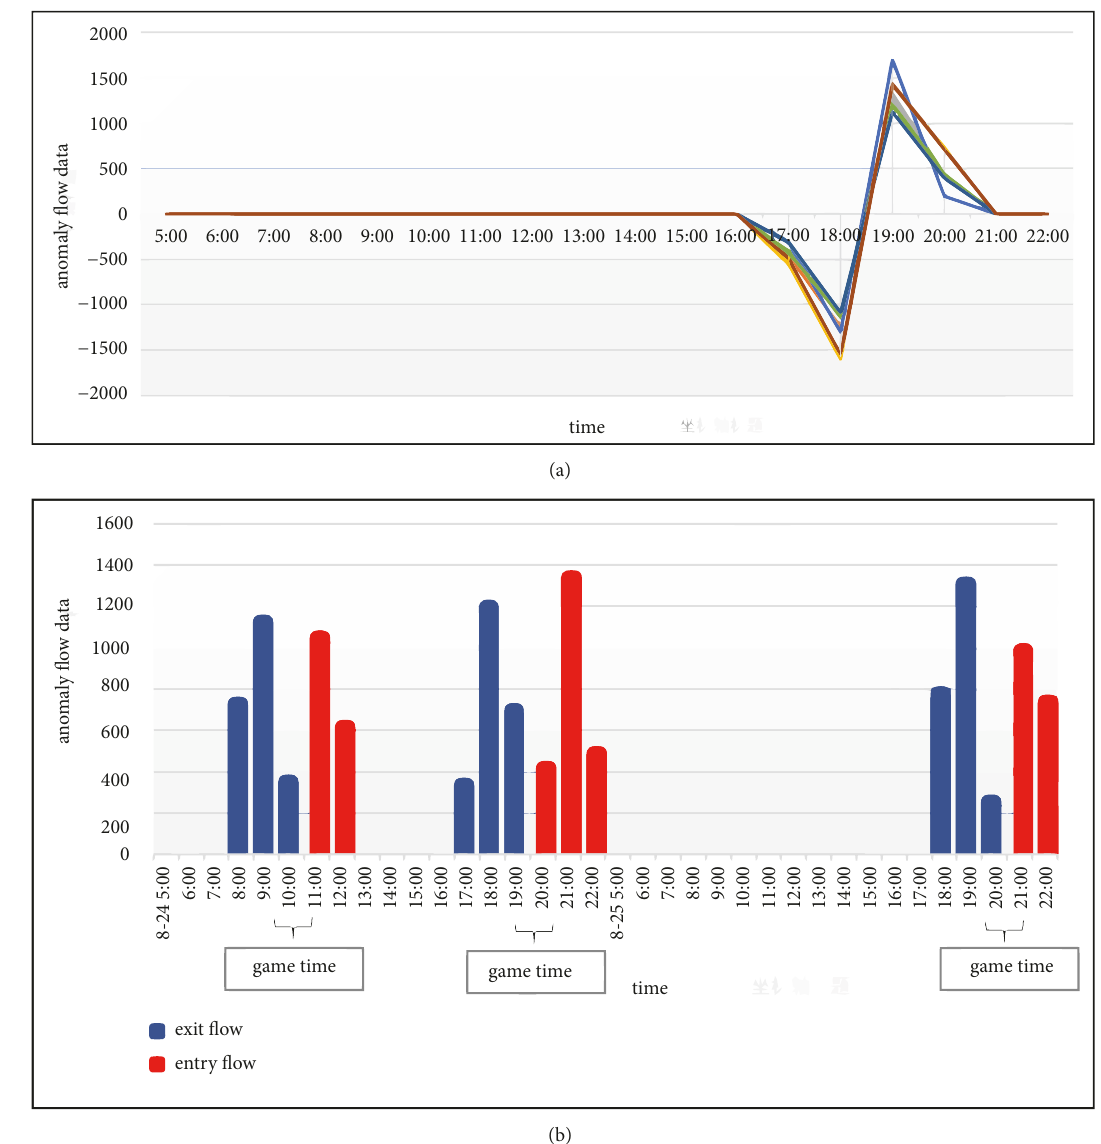
Figure 8: In the two figures, the horizontal axis is time interval and the vertical axis is anomaly flow. (a) shows the exit anomaly flow of multiple stations on August 7; lines represent different stations. From 17:00 to 20:00, there are continuous negative and positive anomalies, because there was a sudden heavy rain at 17:00 that resulted in the passenger flow peak moving back. (b) shows the anomaly flow of Olympic Sports Center Subway Station near the Bird’s Nest stadium. It is obvious that the exit flow surged before the beginning of game and the entry flow surged after the end of